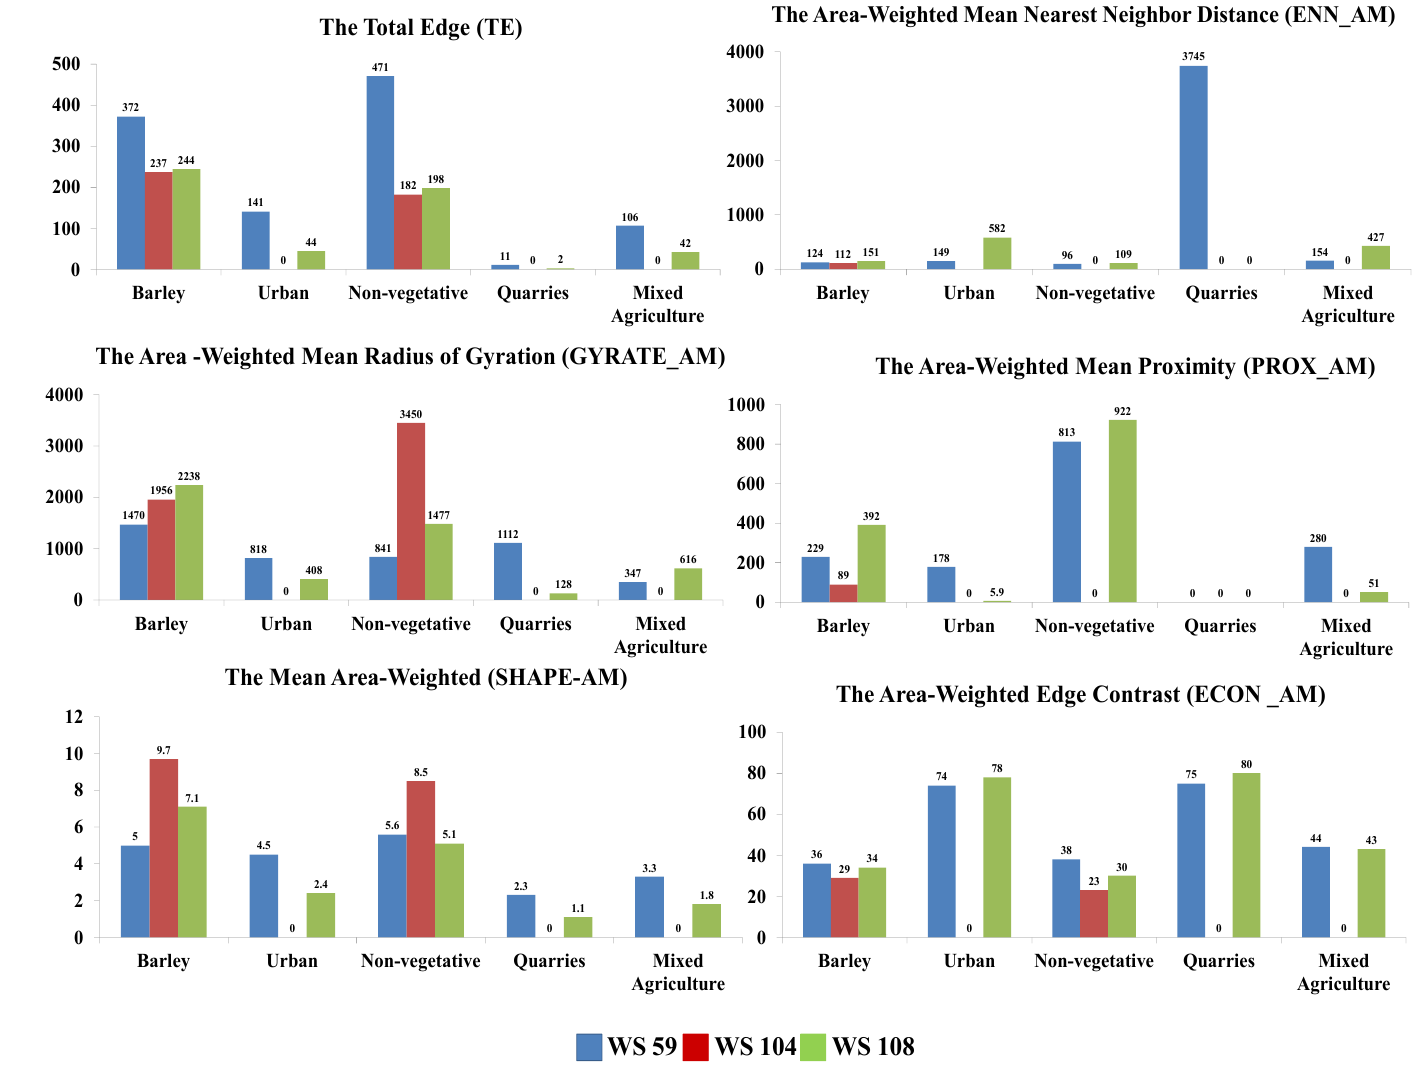
Figure 4. Landscape metrics analysis